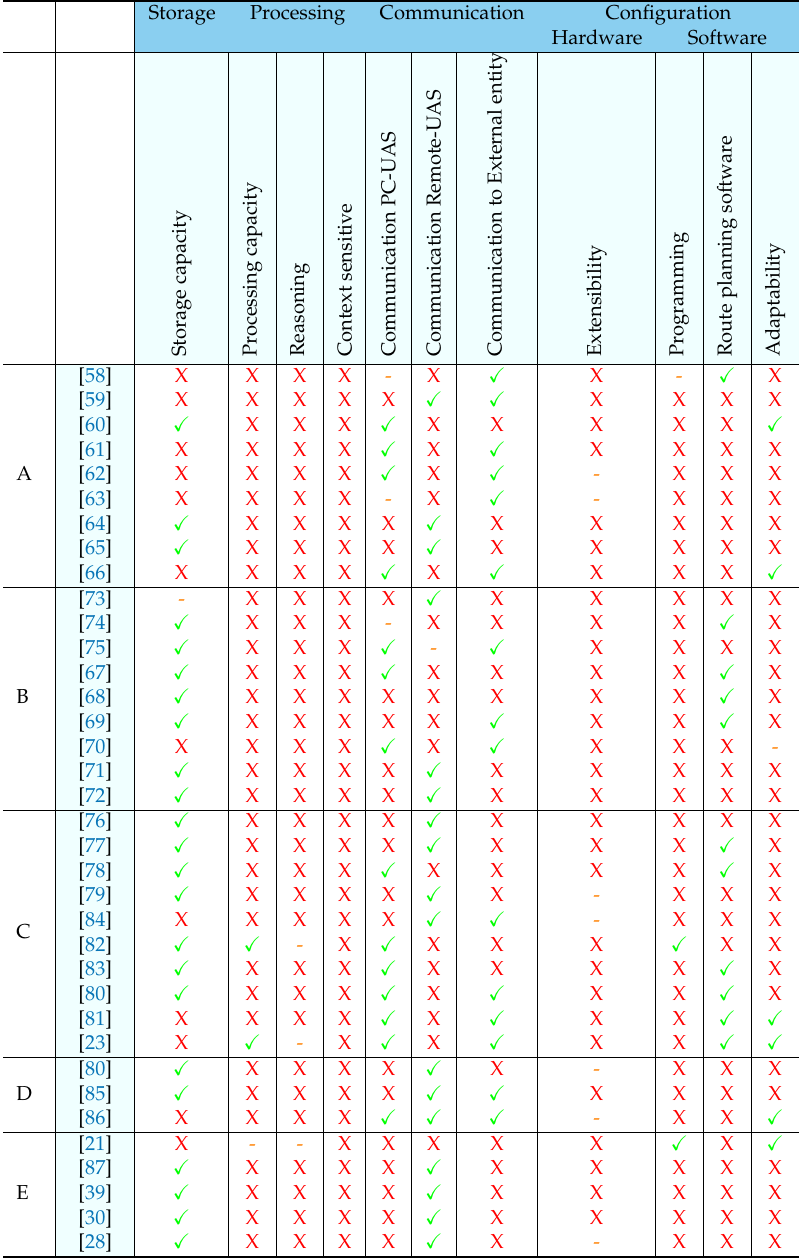
Table 4. Matching between features and DIY